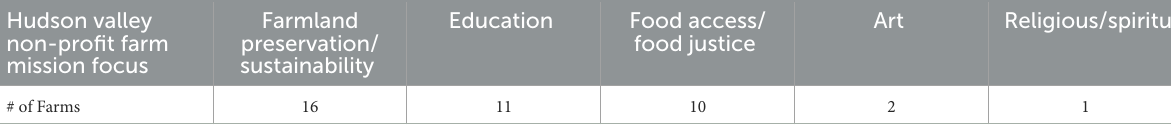
TABLE 4 Missions (multiple) of Hudson valley non-profit farm organizations. 6